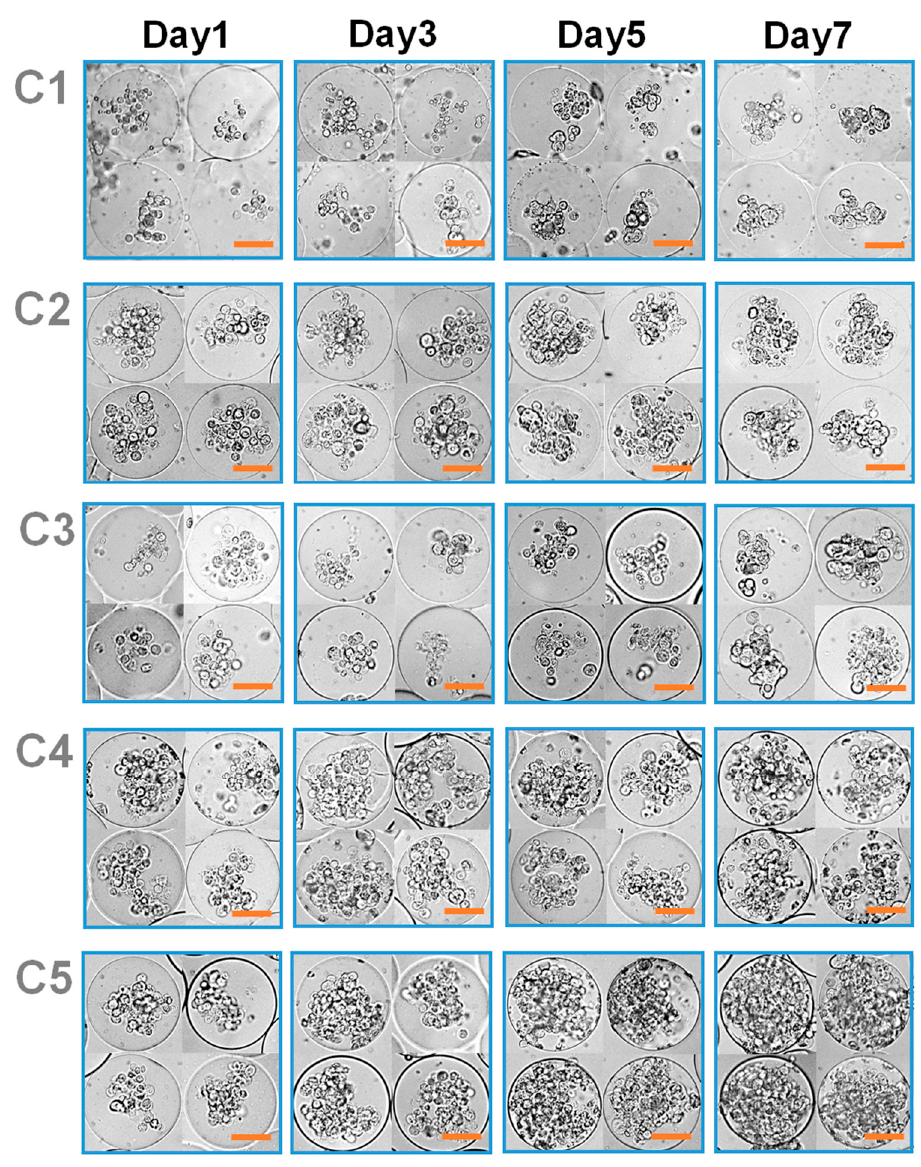
Figure 3. Microscopic images of cell-laden microgels at various mechanical stiffness (from C1 to C5), controlled by MGel concentration, cultured over time (scale: 50 μ m).